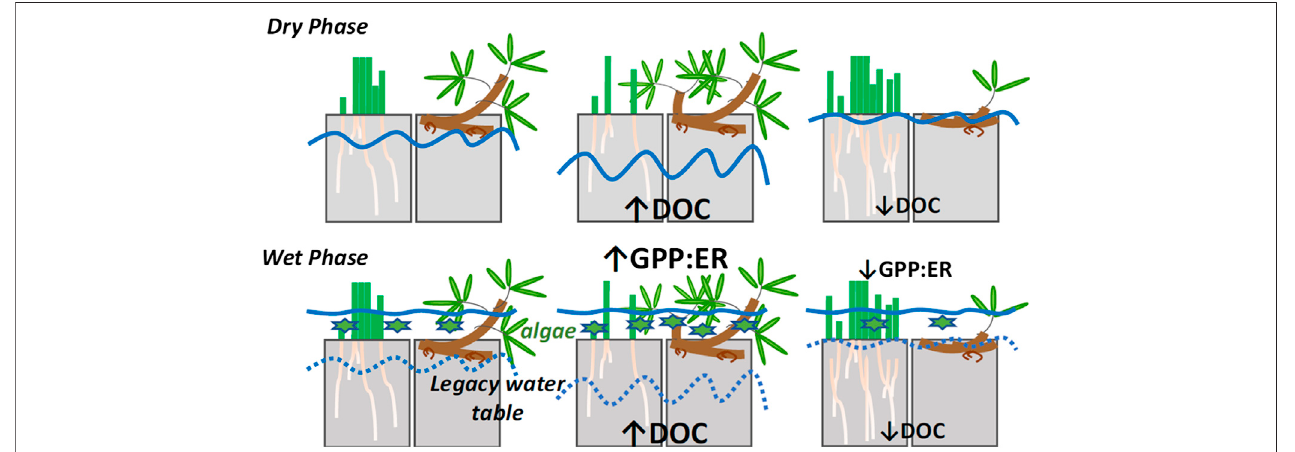
FIGURE 1 | Conceptual model of how our experimental water table treatments (control, lowered and raised) have affected the pool size of nutrients, dissolved organic carbon [DOC] and its quality, and how these factors have affected algal production during fl ooding (wet phase). We hypothesize that these factors affect the balance between gross primary production and ecosystem respiration (GPP:ER). The solid blue lines indicate water table position by treatment, and the dashed lines indicatelegacywatertablepositionduring fl ooding.Thegreenstarsindicatetherelativeabundanceofalgae.Theplantsindicaterelativeabundancesofsedgesand shrubs (see Rupp et al.,